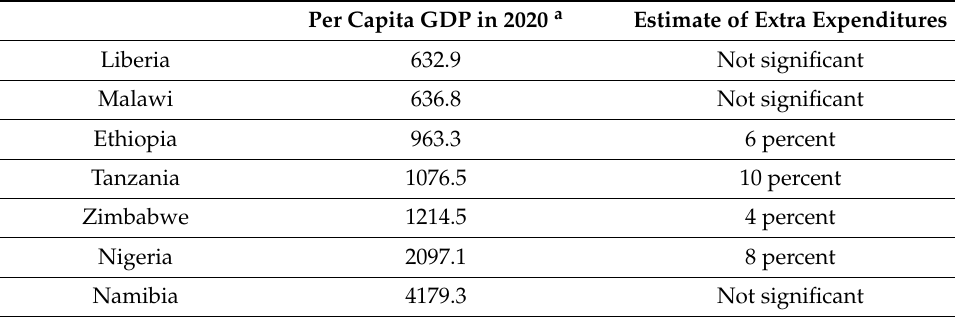
Table 4. Estimates of Extra Expenditures by Per Capita GDP. Per Capita GDP in 2020